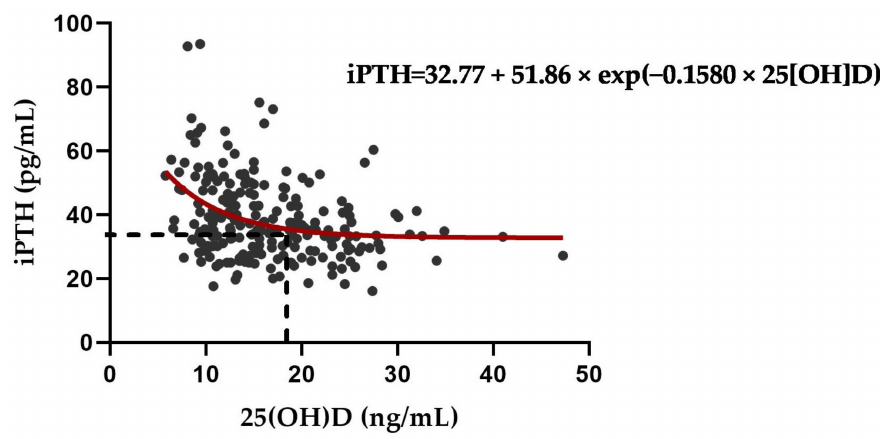
Figure 2. Nonlinear regression between serum 25(OH)D and intact PTH levels in total participants. Serum 25(OH)D levels required to achieve plateau iPTH concentrations were calculated using the following equation: iPTH = a + b × exp (c × 25[OH]D). iPTH increased when the 25(OH)D concentration decreased to 18.44 ng/mL or less.